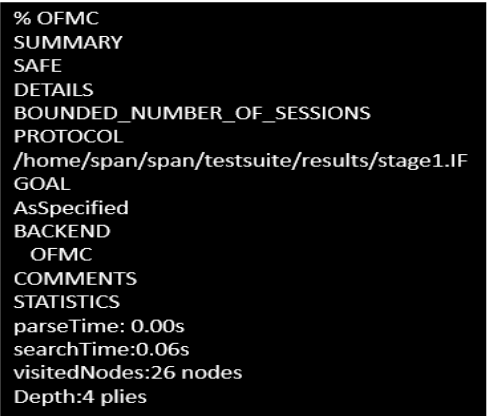
Figure 6. Simulation outcome in stage 1.